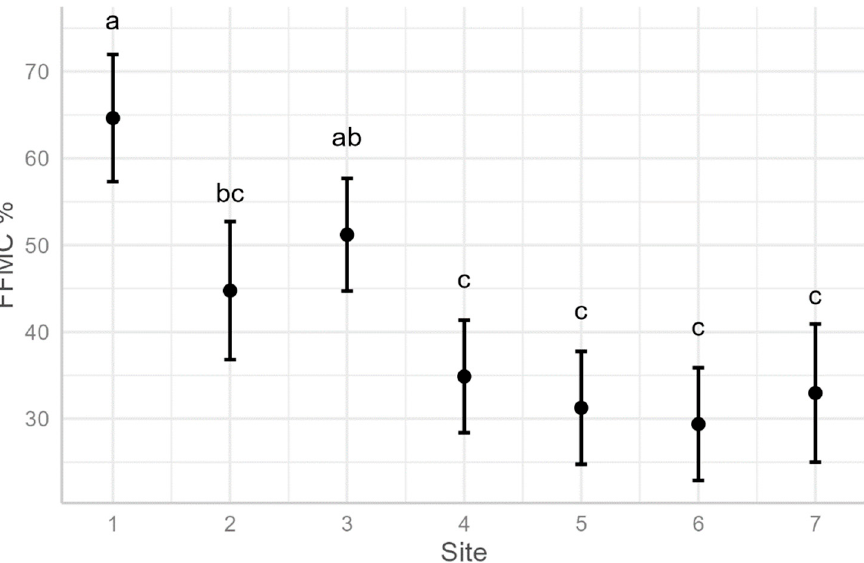
Figure 5. Mean and 95% confidence intervals of the gravimetric fine fuel moisture content (FFMC) in four wet and three dry Eucalyptus forest sites surrounding Hobart, Tasmania (Figures 1 and 2). Letters denote means that are statistically similar according to Tukey’s multiple range tests, where significance differences are defined as p < 0.05).